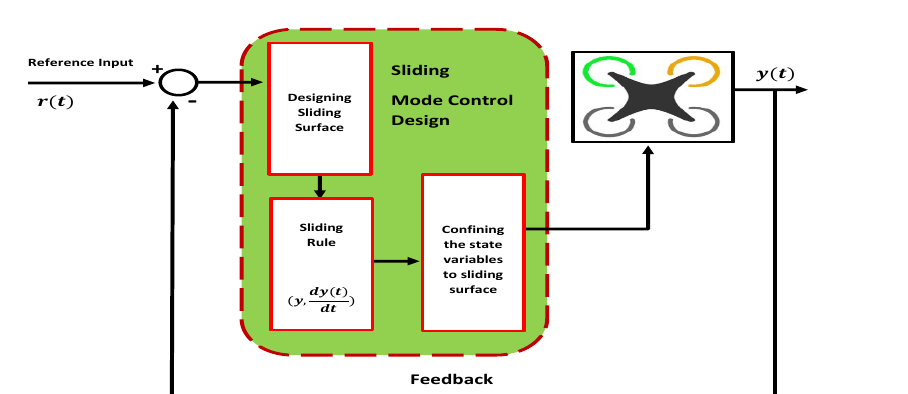
Figure 4. Input membership functions.